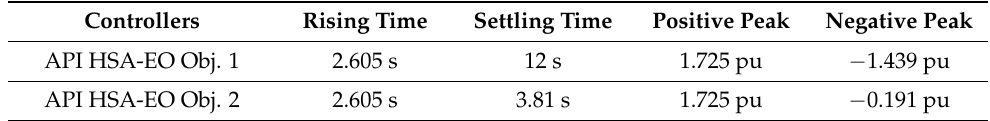
Table 15. Numerical comparison between the controllers at faulty third case.